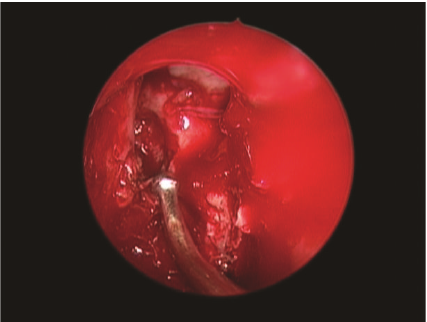
Figure 5: Endoscopic view of bony defect at the junction of eth- moidal sinus and posterior wall of the frontal